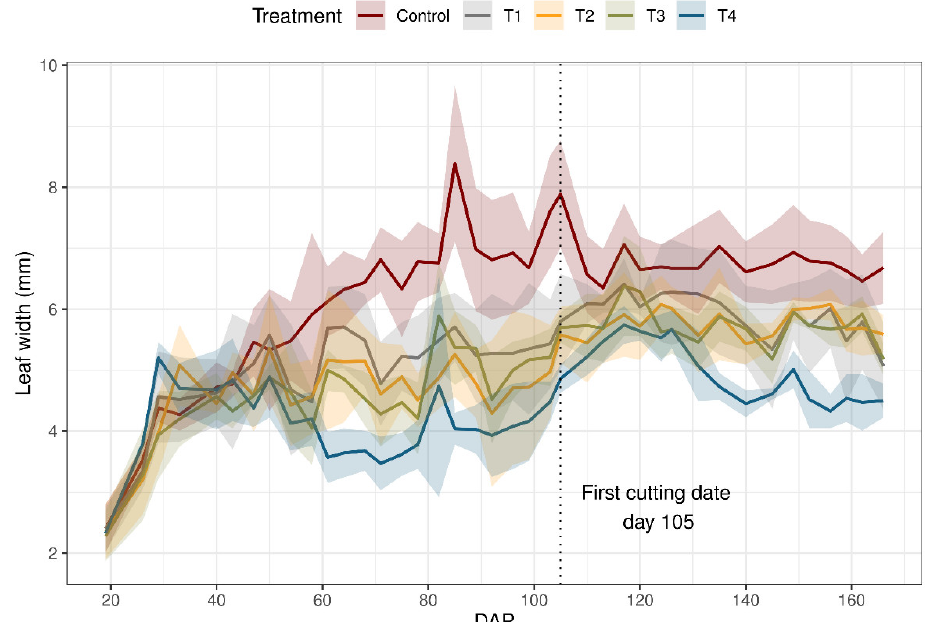
Figure 4. Leaf width (lw) of ryegrass ( Lolium perenne ) during the growing season under different irrigation treatments. Control: non-stressed treatment, T1: moderate–low water stress treatment, T2: moderate–high water stress treatment, T3: medium intensity severe water stress treatment, T4: high intensity severe water stress treatment. The first cutting was made on day 105. The solid line connects the lw means, and the shaded area shows the standard deviation from the mean values.